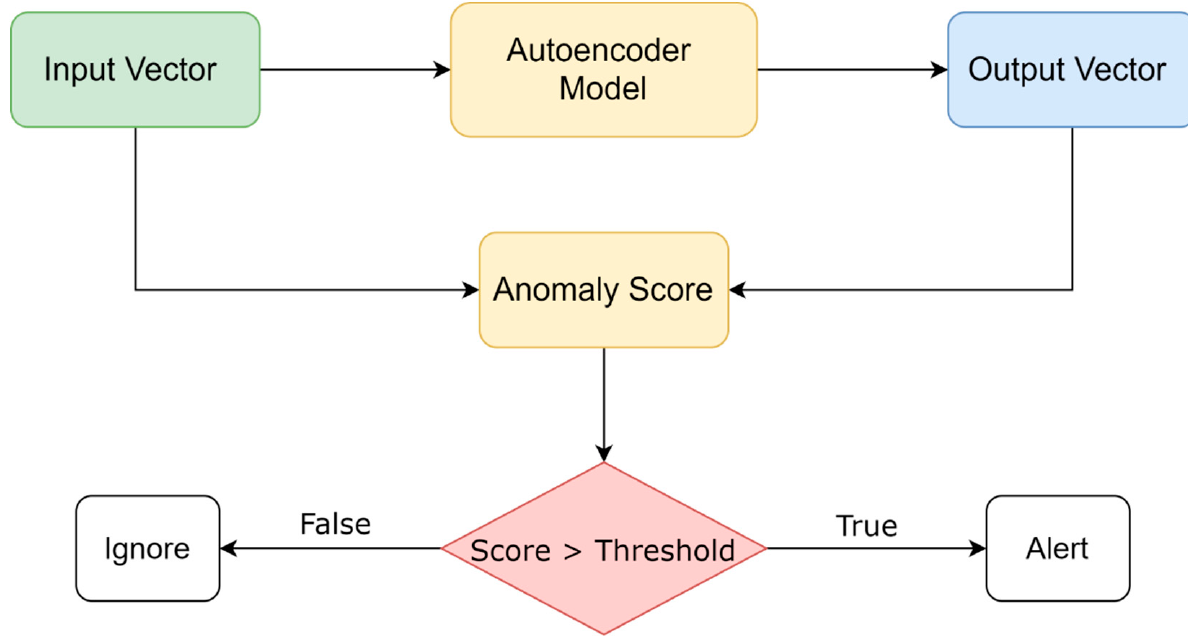
Figure 4. An Illustration of the process of calculating the anomaly score.